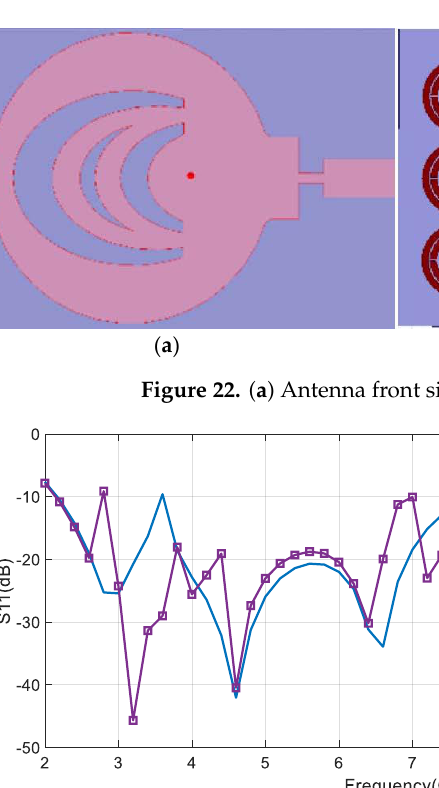
Figure 21. S 11 for antenna with different number of C-SRR.